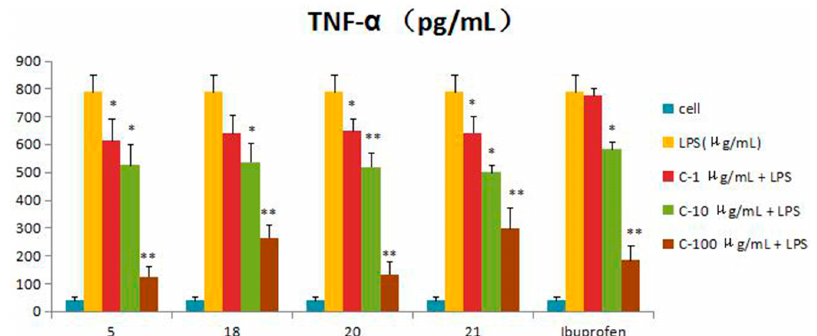
Figure 4. Inhibitory effects of Compounds 5 , 18 , 20 and 21 (1, 10, 100 μ g/mL) on TNF- α production stimulated by LPS (10 μ g/mL) in RAW 264.7 cells (mouse leukemic monocyte macrophage cell line). Data are expressed as the mean ± S.E.M. of three independent experiments. Cell: cultures were not exposed to lipopolysaccharide (LPS); LPS: cultures were subjected to LPS; LPS + Drug: compounds were added to the cultures during LPS; Positive control: LPS + Ibuprofen. ∗ p < 0.05 vs. LPS; ∗∗ p < 0.01 vs. LPS.